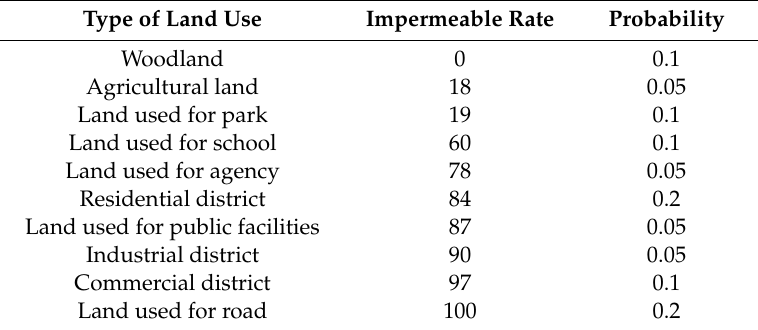
Table 4. Probability for the land use in the Monte Carlo test.